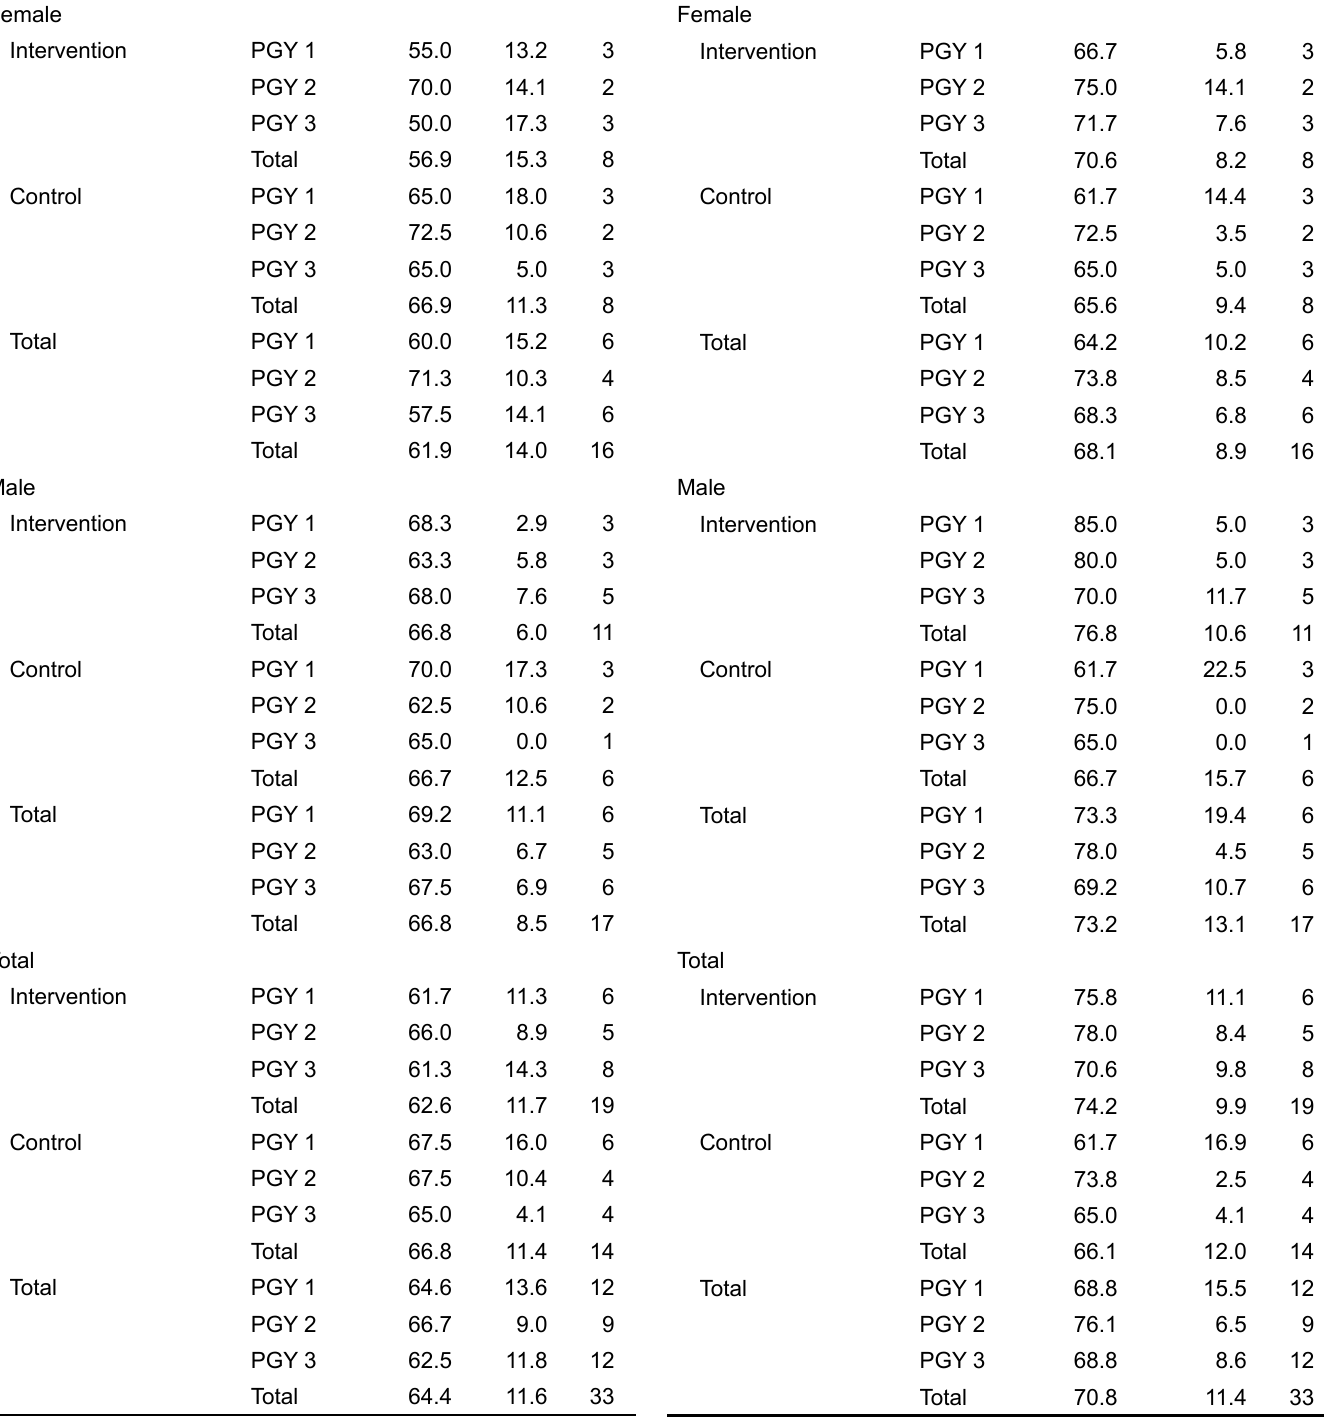
Table 3b. Six-month follow-up emotional intelligence score. De- scriptive statistics (mean, standard deviation [SD], and number) of EI measure for 33 emergency medicine residents broken down by gender, post-graduate year (PGY) and intervention/control groups six months after